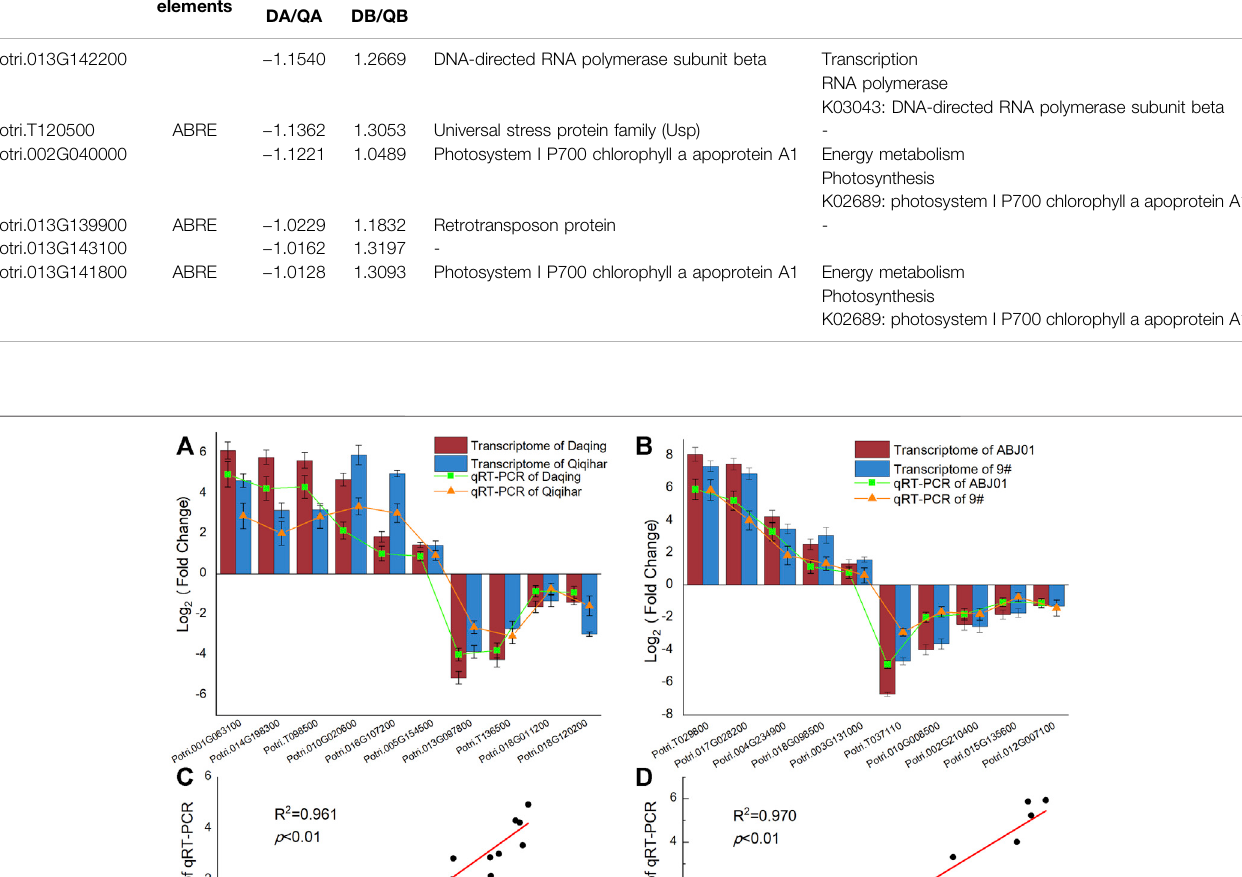
Frontiers in Bioengineering and Biotechnology |